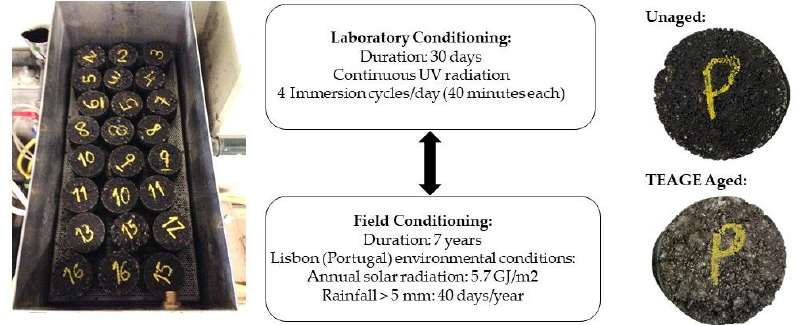
Figure 4. Tecnico accelerated ageing (TEAGE) simulation.